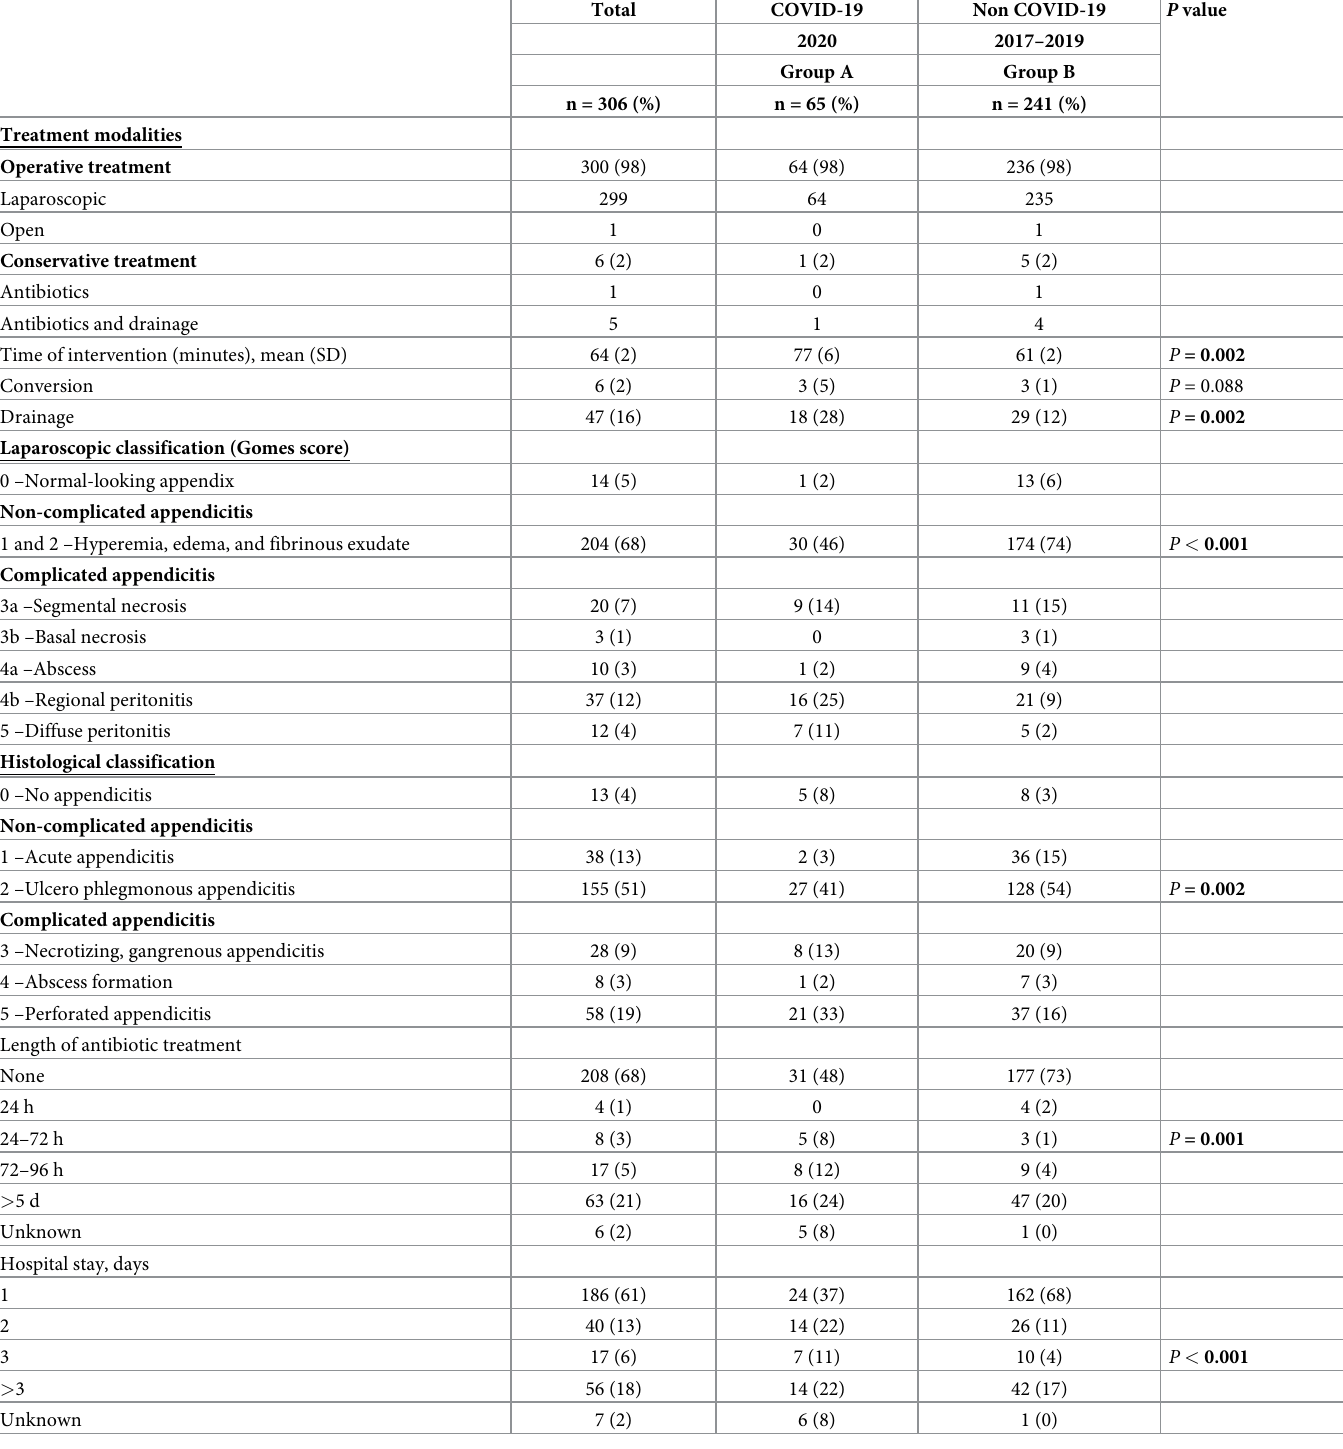
Table 2. Operative and postoperative